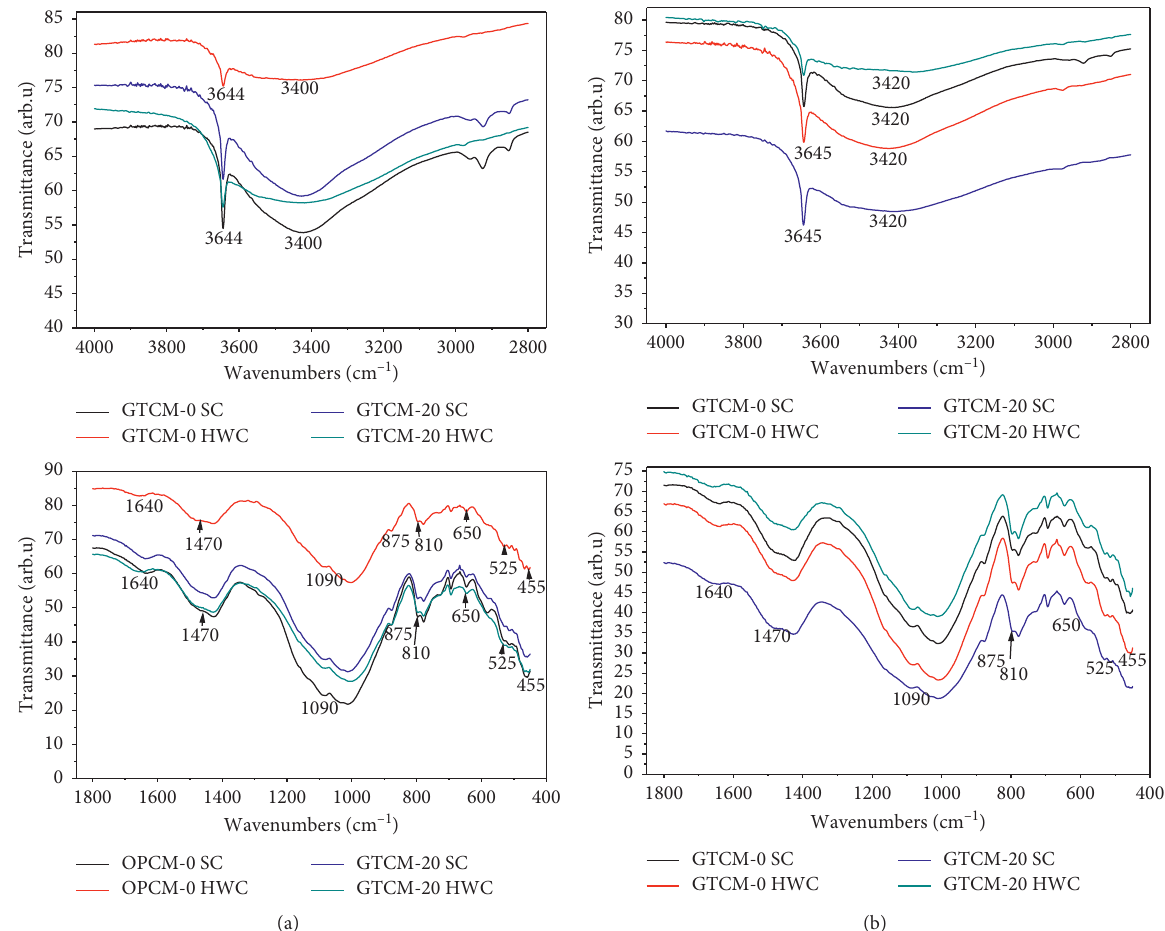
Figure 10: Functional group analysis on GTCM-0 and GTCM-20 under SC and HWC methods: (a) 1 day and (b) 3